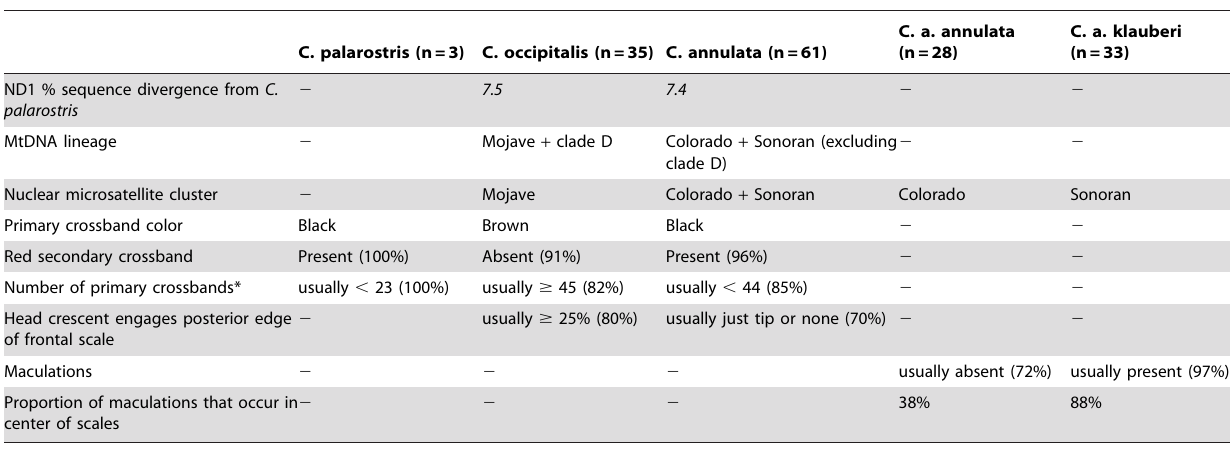
Table 6. Summary of each diagnostic characteristic for the Chionactis species complex based on the multi-locus dataset and Klauber [29]: values (n) below each species/subspecies name refer to the number of snakes for which both genetic & color pattern characters were collected, percentages represent the proportion of snakes that exhibited each phenotypic character.